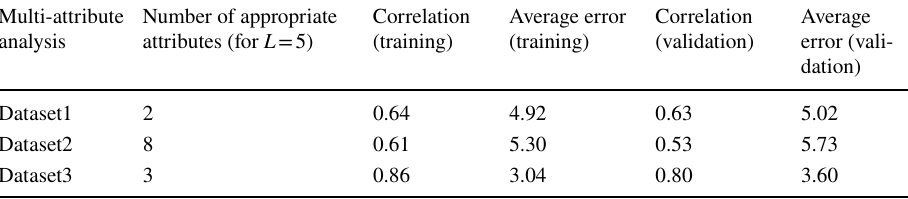
Table 6 The results of applying multi-attribute regression on the